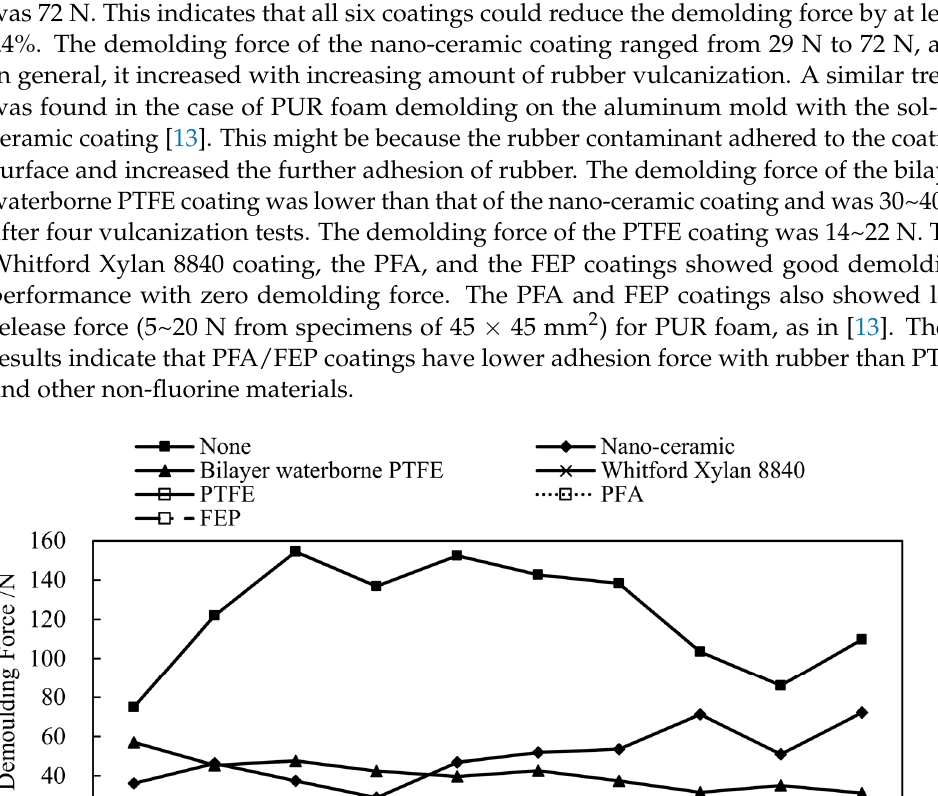
Figure 5. Surface micrographs of the coating surfaces: ( a ) nano-ceramic coating, ( b ) bilayer water- borne PTFE coating, ( c ) Whitford Xylan 8840 coating, ( d ) polytetrafluoroethylene (PTFE) coating, ( e ) perfluoroalkoxy (PFA) coating, ( f ) fluorinated ethylene propylene (FEP) coating.